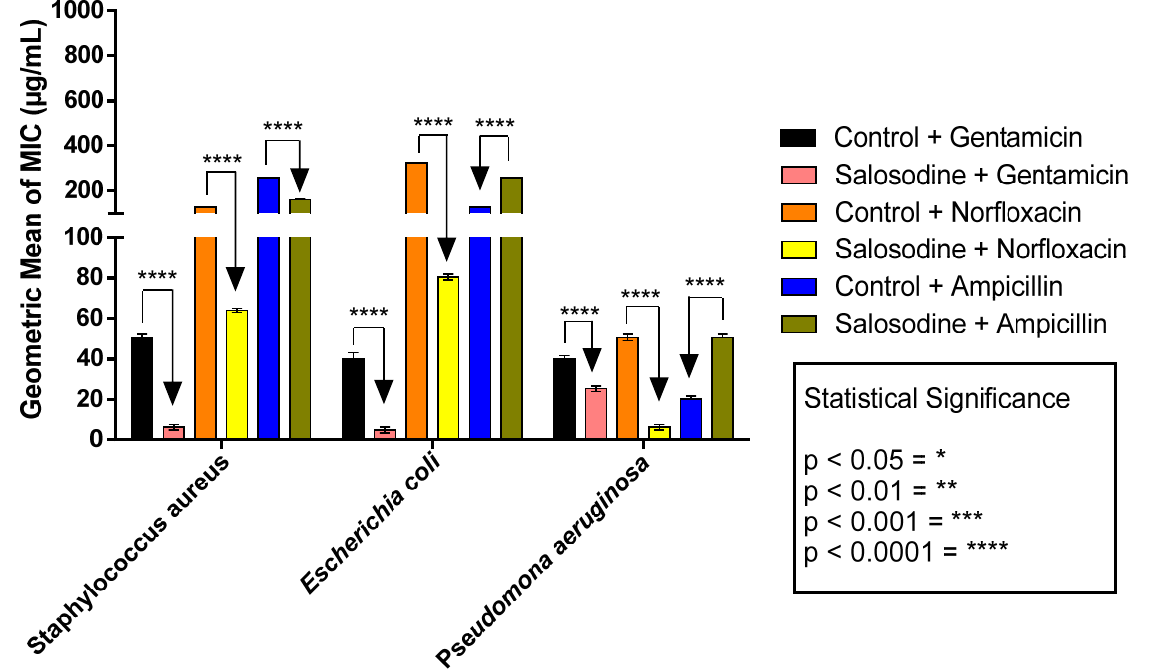
Figure 1. Modifying effect of antibiotics by solasodine against S. aureus 10, E. coli 06, and P. aeruginosa 24. The control refers to antibiotics. **** Statistically significant value when p < 0.0001; not statistically significant when p > 0.05.